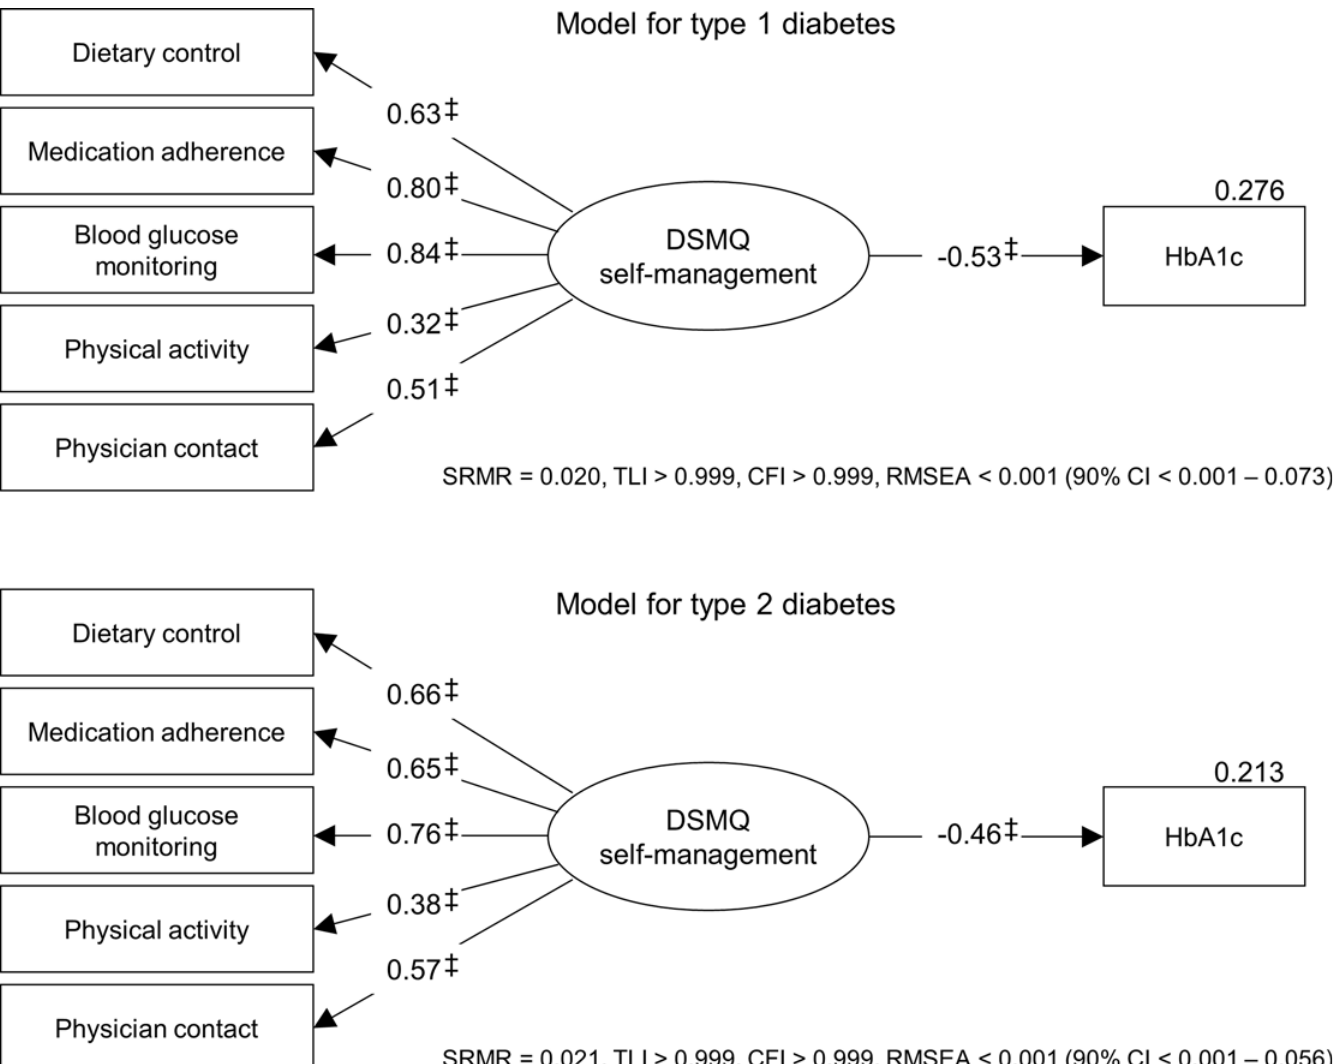
Fig 1. Stuctural equation model of diabetes self-management as measured by the DSMQ and glycaemic control for patients with type 1 and type 2 diabetes. Data are standardised regression weights ( β ) for paths or squared multiple correlations ( R 2 ) for variables. Boxes indicate manifest measurement variables; ovals indicate latent variables operationalised by manifest indicators; error terms are not displayed for ease of presentation. SRMR, Standardised Root Mean Square Residual; TLI, Tucker Lewis Index; CFI, Comparative Fit Index; RMSEA, Root Mean Square Error of Approximation. Indication of two- sided significance: * P < 0.05; † P < 0.01; ‡ P <